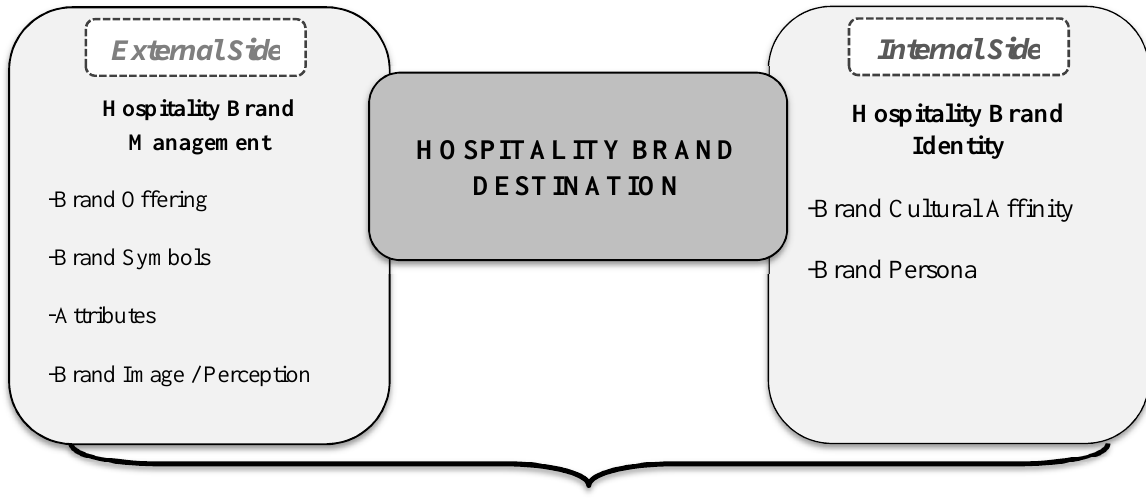
Figure 2: CBM’s Hospitality Brand Management